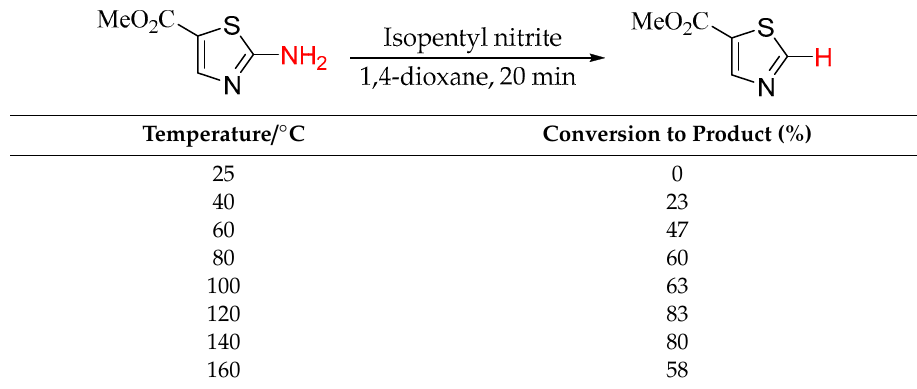
Table 3. Conversion of methyl 2-aminothiazole-5-carboxylate ( 1a ) to methyl thiazole-5-carboxylate ( 2a ) at various temperatures in 1,4-dioxane.